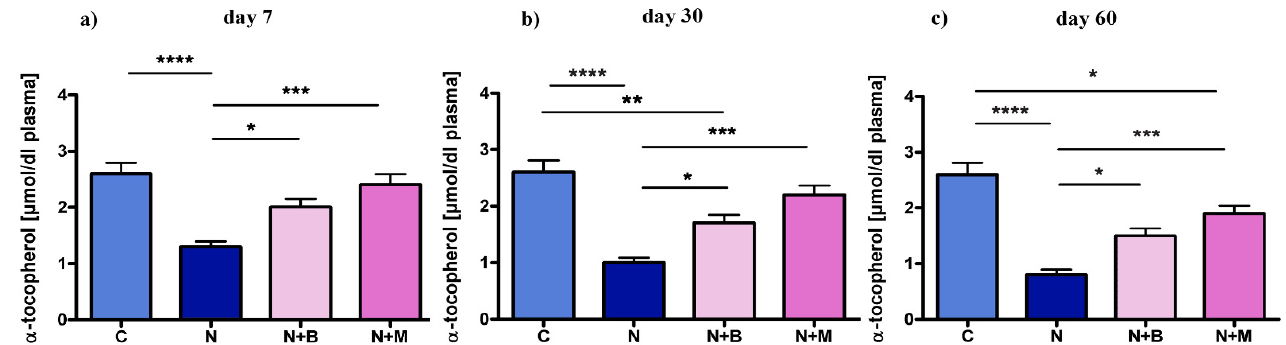
Figure 3. Content of α -T in plasma under chronic acoustic stress conditions. Animals ( n = 6) were treated for 60 days with noise (N) or left untreated (C). Mesedin (M) and beditin (B) were injected daily i.p. to the rats exposed to chronic noise (N + M and N + B, respectively). One-way ANOVA with Sidak’s multiple comparison test, * p < 0.05, ** p < 0.01, *** p < 0.001, **** p > 0.0001. The mean ± SEM values of plasma content of α -T on days 7, 30, and 60 after exposure of noise and mesedin/beditin are shown in ( a ), ( b ) and ( c ) respectively.